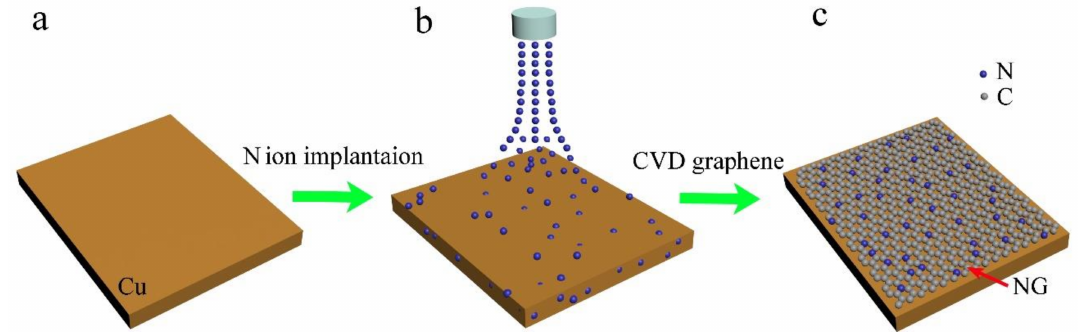
Figure 1. Diagram of N-doped graphene synthesis process: ( a ) polycrystalline Cu foils after cleaning; ( b ) pre-implantation of N ions in Cu substrates; ( c ) NG deposition on Cu surface.